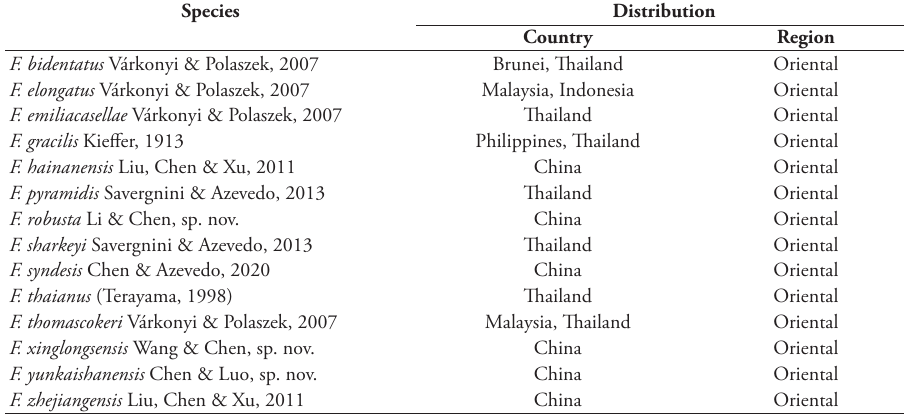
Table 3. List of the world species of Foenobethylus (updated from Chen and Azevedo